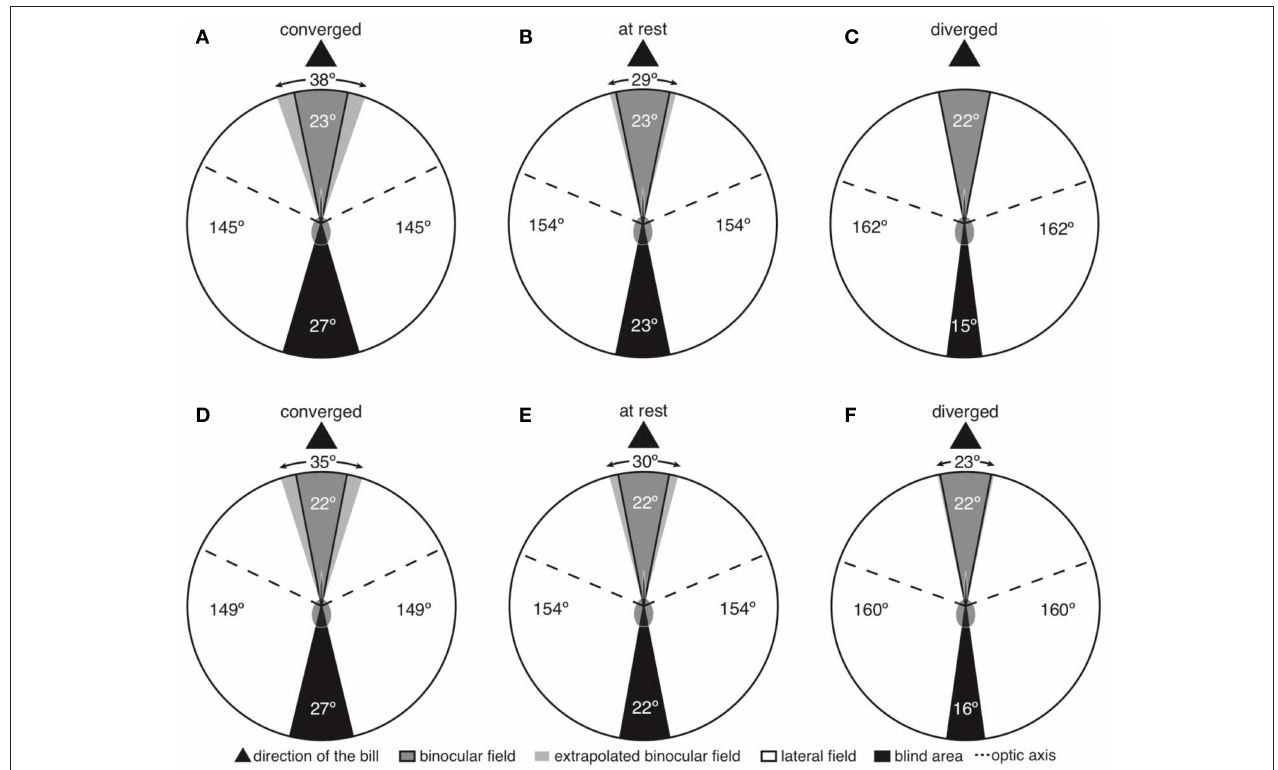
FIGURE 1 | Two-dimensional representations of horizontal sections through the visual fields of Anna’s (A–C) and Rufous (D–F) hummingbirds. Panels are labeled according to whether the panel presents the eyes moved forward in a converged state, resting in an at rest state, or moved backward in a diverged state.